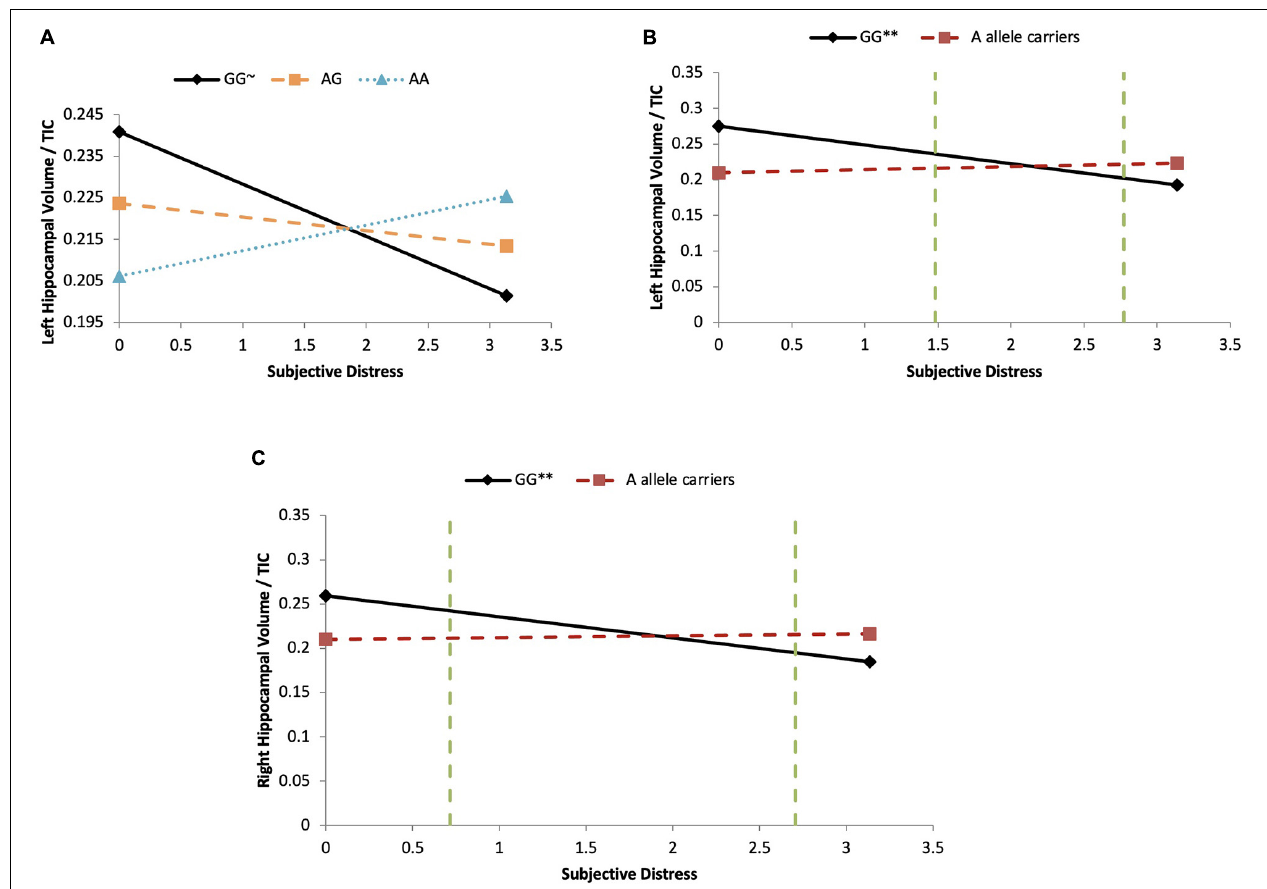
FIGURE 4 | COMT moderates subjective distress on left HCV/TTV ratio in girls. (A) Major homozygotes vs. heterozygotes vs. minor homozygotes: Moderation analyses demonstrate that there is a significant COMT-by-subjective distress interaction effect on left HCV/TIV ratio in girls ( p = 0.047). For the minor homozygote (AA genotype, dotted line) and heterozygote (AG genotype, dashed line) there is no association between subjective distress and left HCV/TIV ratio ( p = 0.165 and p = 0.409, respectively). For major homozygote (GG genotype, solid line) there is a marginally significant negative association between subjective distress and left HCV/TIV ratios ( p = 0.092). There are no statistical significance transition points within the observed range of the predictor. ∼ p < 0.10. (B) Major homozygotes vs. minor allele carriers on left HCV/TIV ratio: Moderation analyses demonstrate that there is a significant COMT-by- subjective distress interaction effect on left HCV/TIC ratio in girls ( p = 0.001). For major homozygotes (GG genotype, solid line), there is a significant negative association between subjective distress and left HCV/TIV ratio ( p = 0.0026) but for minor homozygotes and heterozygotes (AA and AG genotypes, red dashed line) there is no association between subjective distress and left HPV/TIV ratio ( p = 0.129). There are regions of significance ( p < 0.05) such that below log-transformed subjective distress levels of 1.48 and above 2.77 there is a significant difference between left HCV/TIV ratio of major homozygotes and minor-allele carriers. ∗∗ p < 0.01. (C) Major homozygotes vs. minor allele carriers on right HCV/TIV ratio: Moderation analyses demonstrate that there is a significant COMT-by-subjective distress interaction effect on right HCV/TIC ratio in girls ( p = 0.007). For major homozygotes (GG genotype, solid line) there is a significant association between subjective distress and right HPV/TIV ratio volume ( p = 0.008); however, for minor homozygotes and heterozygotes (AA and AG genotypes, red dashed line) there is no significant association between subjective distress and HCV/TIV ratio ( p = 0.272). There is a region of significance ( p < 0.05) between genotypes below log-transformed subjective distress levels of 0.717 and above 2.705, such that right HCV/TIC ratio were significantly different between the major homozygotes and the minor-allele carriers. The two green dashed lines indicates the regions of significance. ∗∗ p <